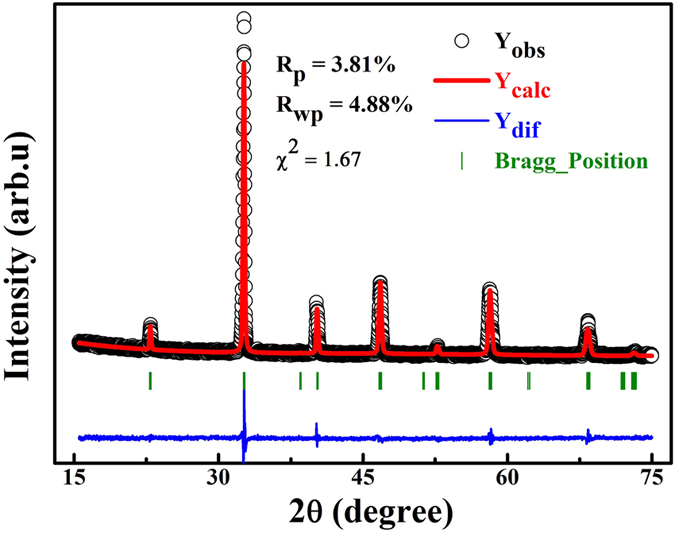
Room temperature XRD and refinement result of sample La0.5Sr0.5Mn0.8Co0.2O3.The observed and calculated patterns are denoted by circle and solid line, respectively. The blue solid line at the bottom of the panel shows the difference of the observed and calculated patterns. Green bars correspond to Bragg positions.